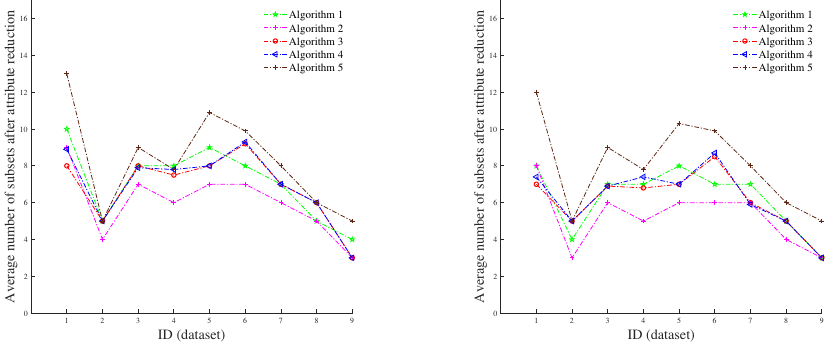
Figure 5. Average number of attribute subsets after five different attribute reductions.